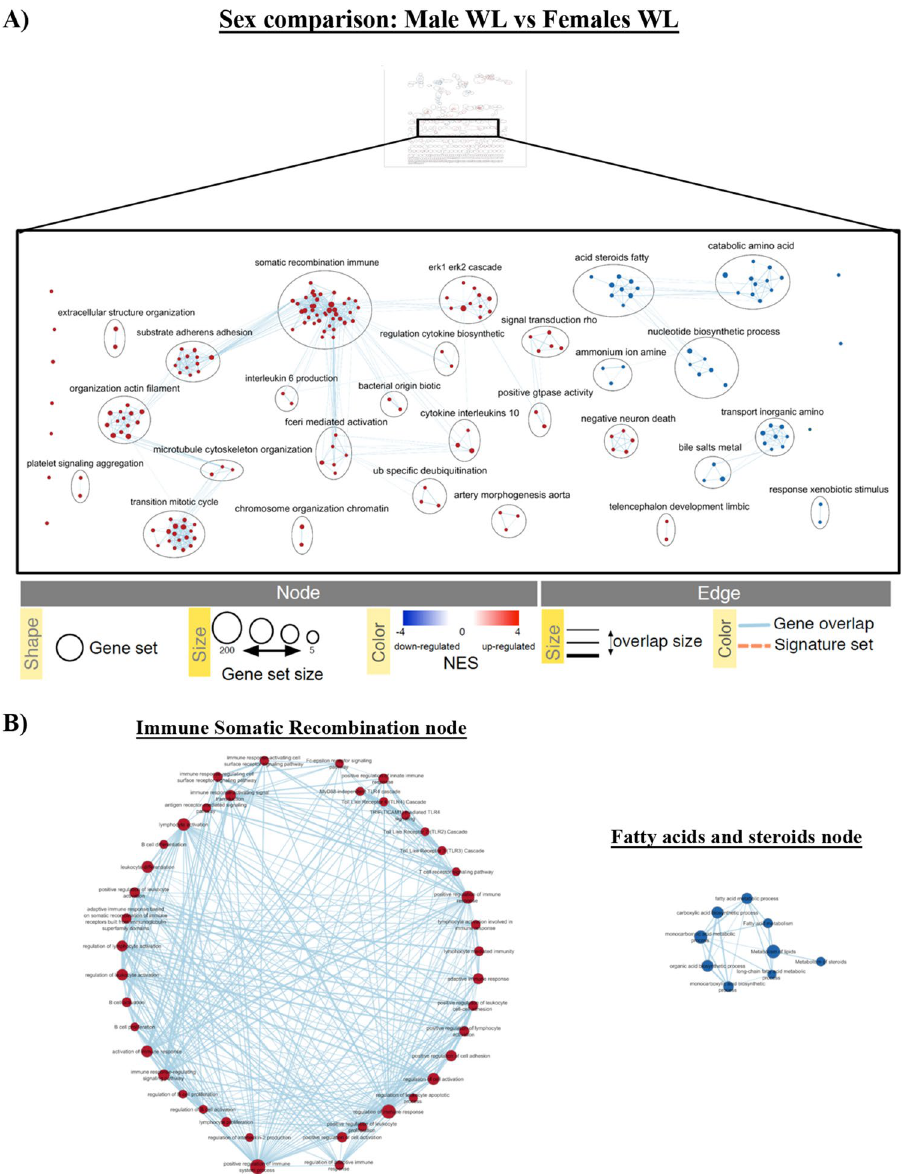
Figure 6. Enrichment map example of over-represented genes in individual sex comparisons M.WL versus F.WL following GSEA analyses. ( A ) Representation of different clusters (nodes) regulated in the comparison. The map allows visualization of clusters containing nodes in which red and blue represent up- or down- regulated gene sets for each node, respectively. The clusters take their name from the most common containing names of the nodes within the cluster. ( B ) Example of the different gene sets that form somatic recombination immune and acid steroids fatty nodes, where red and blue nodes represent up- or down-regulated gene sets, respectively (FDR: